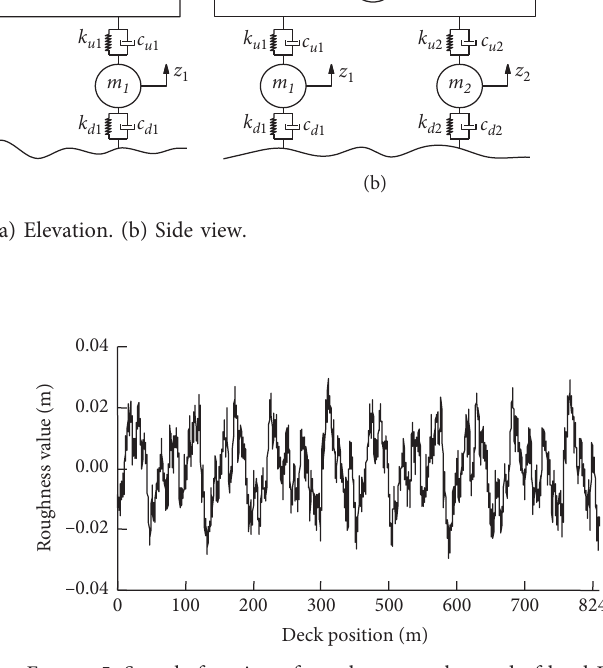
Figure 5: Sample function of roughness on the road of level